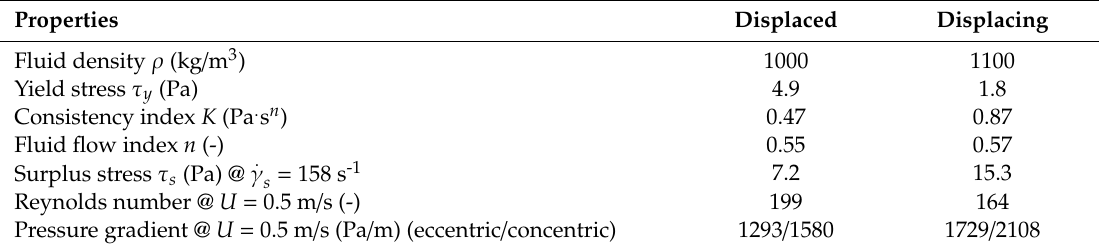
Table 5. Transport properties for the barite free two-fluid